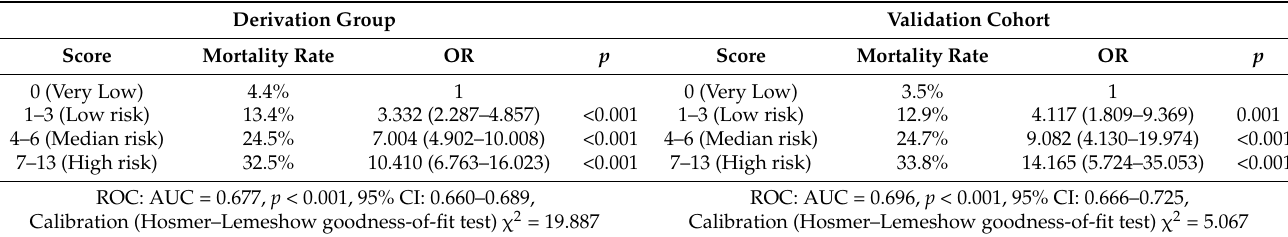
Table 3. Risk of 30-day mortality in the derivation and validation